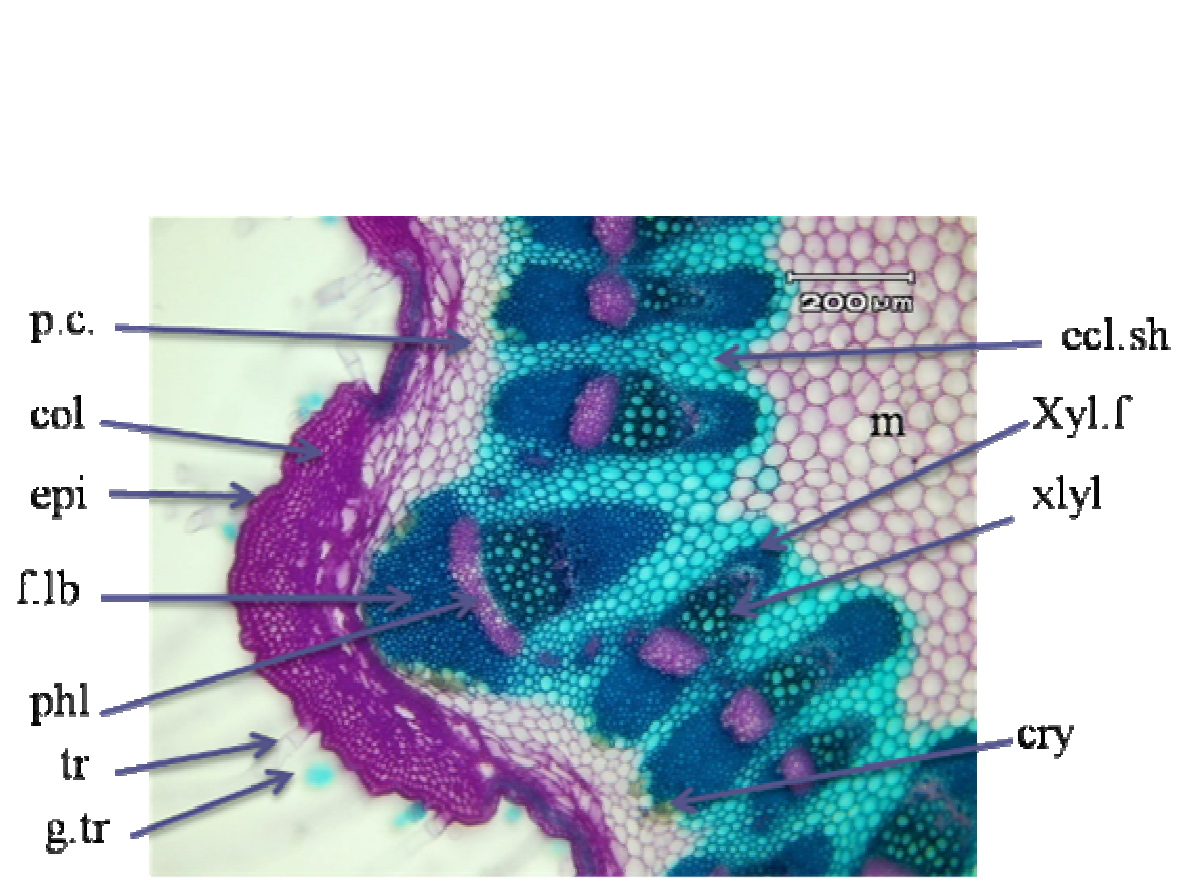
Fig. 7. The cross section of stem, in O. armenum . Tr: Trichome, G. Tr: Glandular Trichome, Epi: Epiderm, Col: Collenchyma, P. C: Parenchyma, Ecl. Sh: Sclerenchyma, F. Lb: Phloem Fiber, Phl: Phloem, Xyl; Xylem, Xul. F: Xylem Fiber, Cry: Crystal, M: Medulla. 00µm in B, E, K, H; Scale bar=200 µm; X=